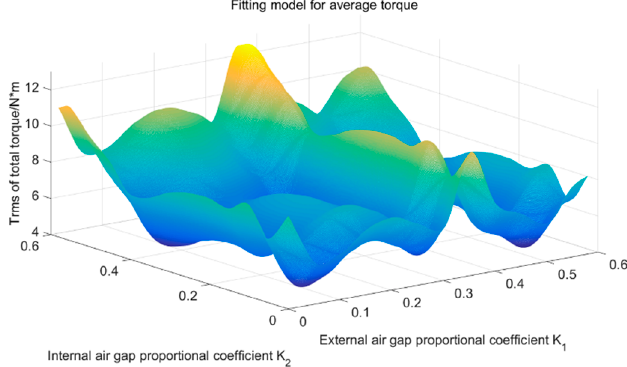
Figure 8. Three-dimensional fitting diagram of the average torque. Figure 9. Three-dimensional fitting diagram of the average torque.